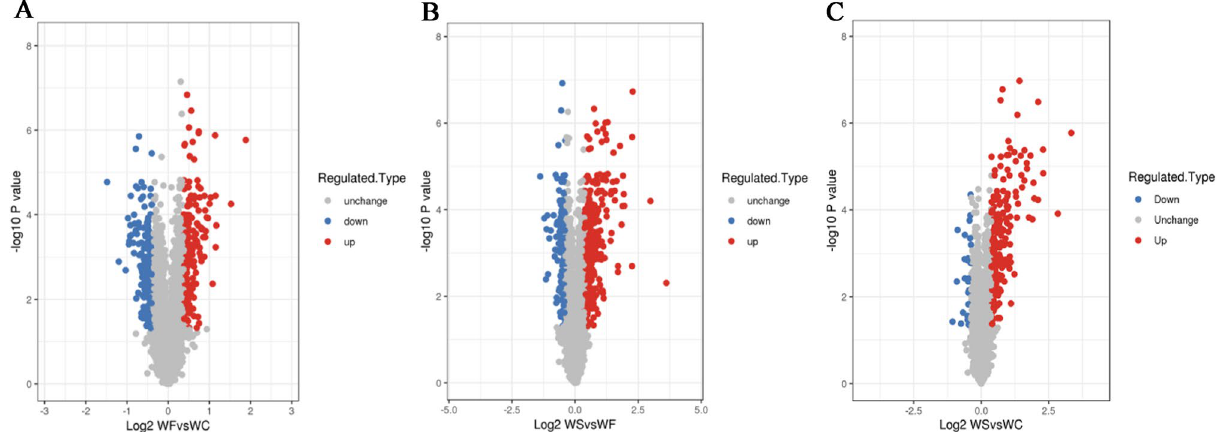
Figure 2. Volcano plots of differentially expressed proteins in the (A) WF/WC, (B) WS/WF and (C) WS/WC groups. The horizontal axis is the relative quantitative value of protein after log2 conversion, and the vertical axis is the value of the P-value after − log10 conversion. Red and blue dots indicates significantly up-regulated and down-regulated proteins,